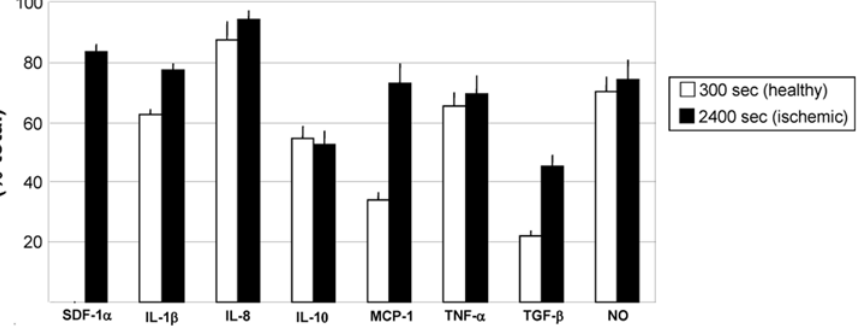
Figure 4. The ABM reproduced increased exposure of circulating monocytes to inflammatory chemokines and cytokines. Prior to ischemic insult, circulating monocyte exposure to soluble and surface-bound chemokines was relatively low (t=300 seconds; chemokines secreted by monocytes, ECs, tissue macrophages at baseline and WSS-induced changes). After ischemic insult and for duration of simulations (t=300– 2400 seconds), a higher percentage of monocytes encountered chemokines and cytokines, a hallmark of ischemic injury in humans. This led to additional surveying, rolling, firm adhesion, and extravasation by circulating cells. Reported are mean values + standard deviation (n=5).